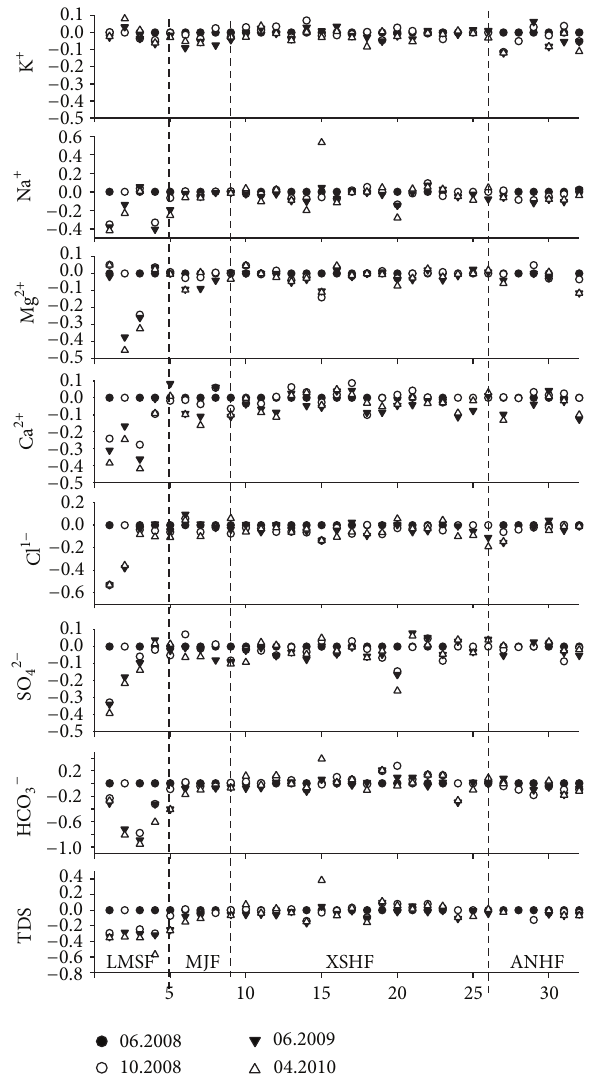
Figure 4: Temporal variations of the geochemical parameters of the 32 hot spring waters after the Wenchuan earthquake. The abscissas indicate the numbers of the samples and the ordinates indicate the ratios of each batch of samples with the first batch of samples.